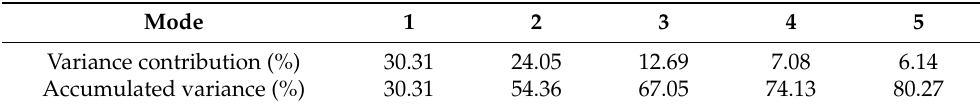
Figure 2. Spatial distribution ( the left ) and time coefficients ( the right ) of first three modes of EOF analysis of humidity index in five provinces of Northwest China. Table 2. Statistical results for the first 5 modalities obtained by empirical orthogonal function (EOF).